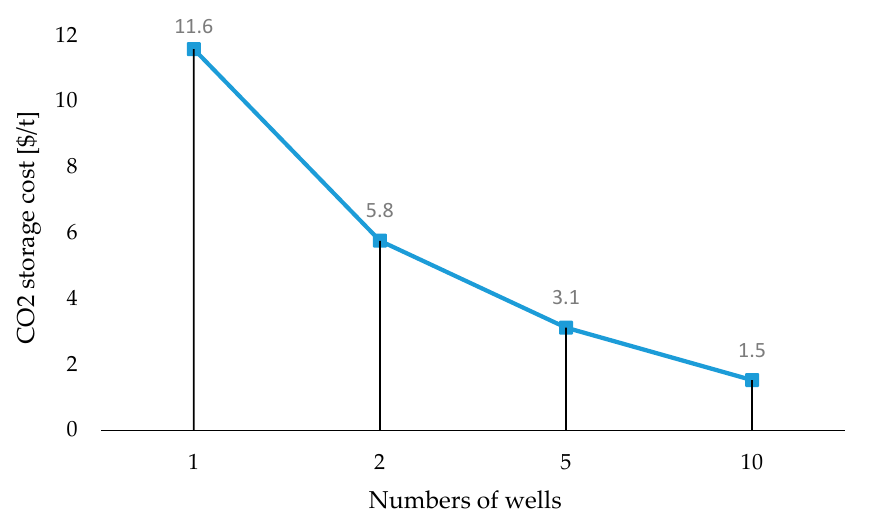
Figure 14. CO 2 storage cost at different numbers of wells when a combined method that includes CO 2 replacement and depressurisation of the NGH reservoir is applied to produce methane.